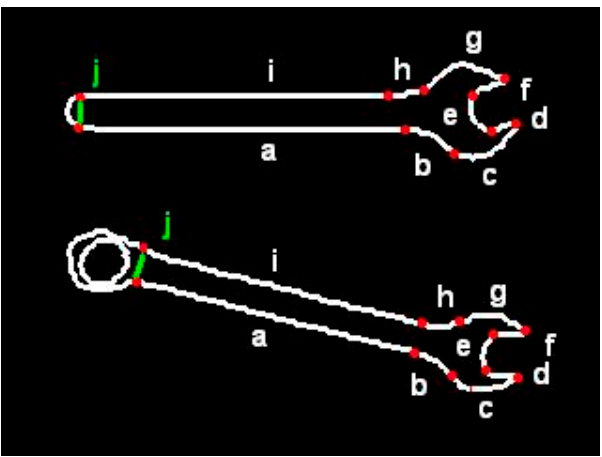
Figure 3. Visualization of flexible template containing a virtual segment.